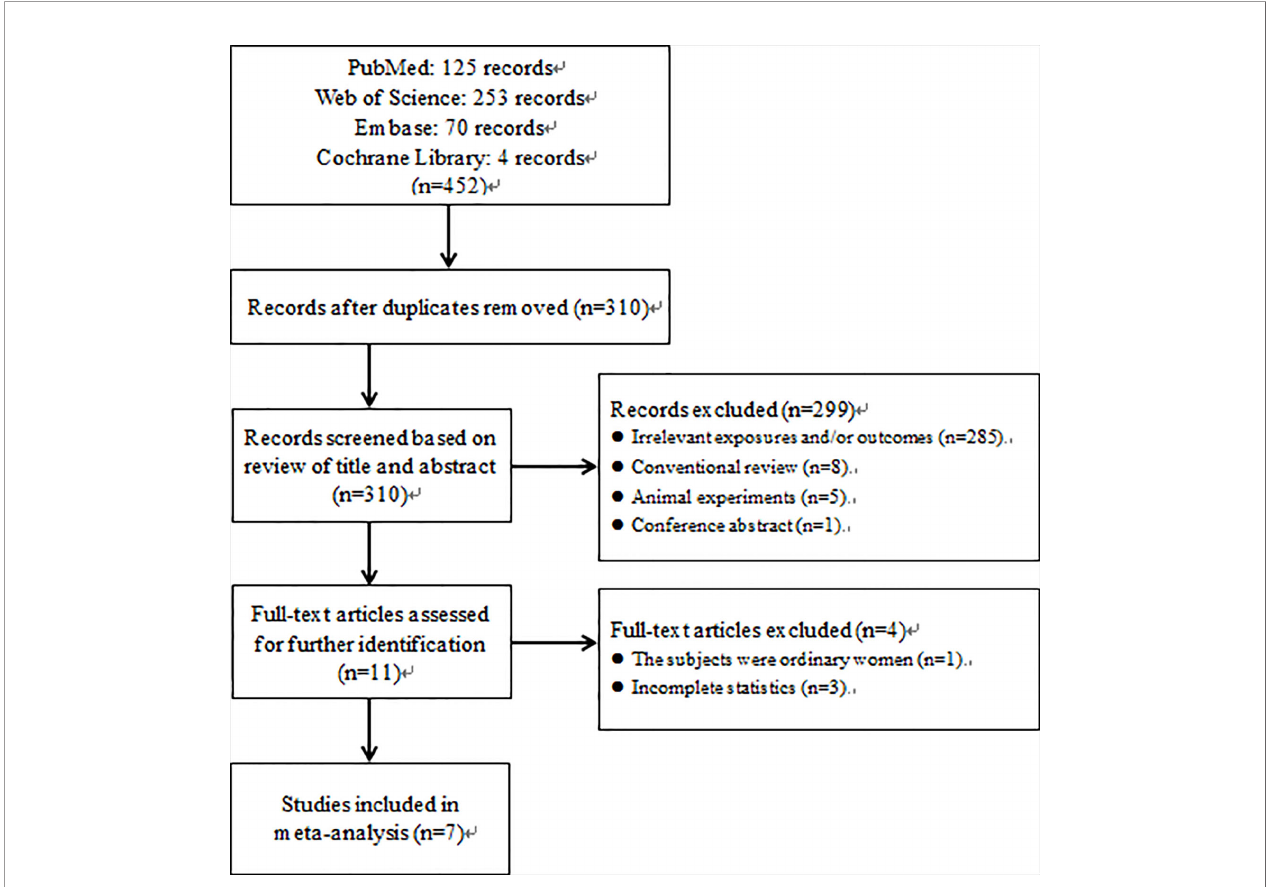
FIGURE 1 | Flow diagram of selection of eligible